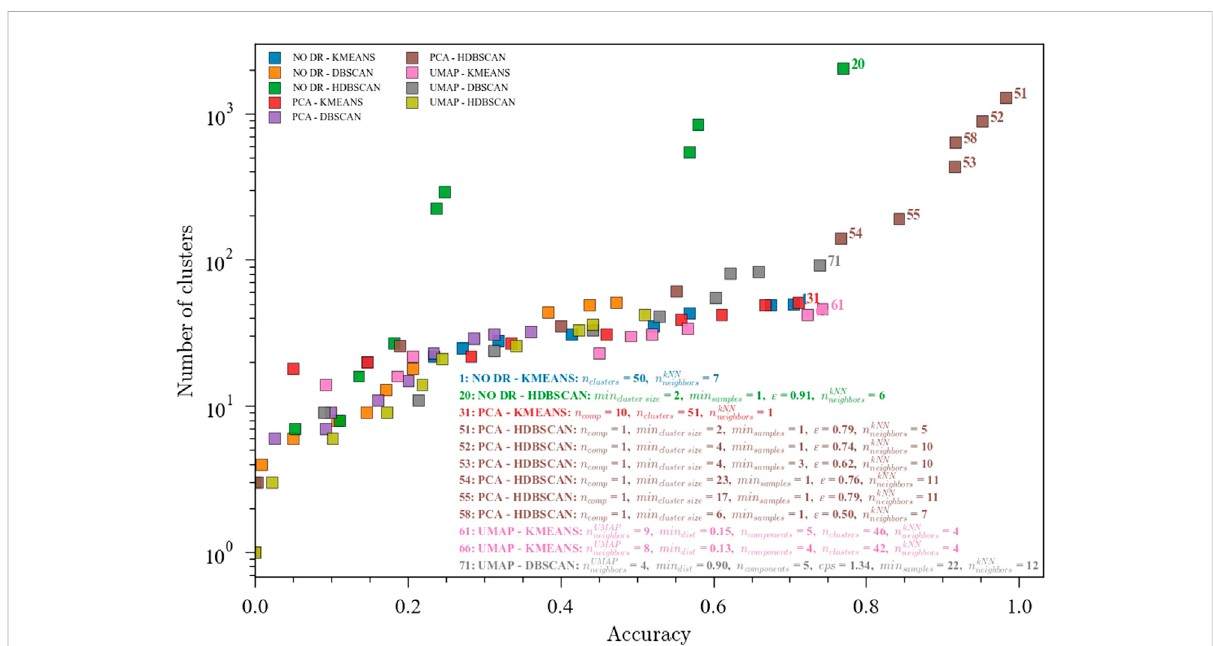
FIGURE 3 Paretofrontsforthemulti-objective(accuracy andnumberofclusters)optimizationoftheensembles.The hyperparametersfortheaccuracies above0.70 areshown. Data fromtheTennesseeEastman Process dataset with 20faults. Ensembles:(1) NO DR-KMEANS, n clusters (cid:1) 50, n kNN neighbors (cid:1) 7; (20) NO DR-HDBSCAN, min cluster size (cid:1) 2, min samples (cid:1) 1, ε (cid:1) 0 . 91, n kNN neighbors (cid:1) 6; (31) PCA-KMEANS, n components (cid:1) 10, n clusters (cid:1) 50, n kNN neighbors (cid:1) 1; (51) PCA-HDBSCAN, n components (cid:1) 1, min cluster size (cid:1) 2, min samples (cid:1) 1, ε (cid:1) 0 . 79, n kNN neighbors (cid:1) 5; (52) PCA-HDBSCAN, n components (cid:1) 1, min cluster size (cid:1) 4, min samples (cid:1) 1, ε (cid:1) 0 . 74, n kNN neighbors (cid:1) 10; (53) PCA-HDBSCAN, n components (cid:1) 1, min cluster size (cid:1) 4, min samples (cid:1) 3, ε (cid:1) 0 . 62, n kNN neighbors (cid:1) 10; (54) PCA- HDBSCAN, n components (cid:1) 1, min cluster size (cid:1) 23, min samples (cid:1) 1, ε (cid:1) 0 . 76, n kNN neighbors (cid:1) 11; (55) PCA-HDBSCAN, n components (cid:1) 1, min cluster size (cid:1) 23, min samples (cid:1) 1, ε (cid:1) 0 . 79, n kNN neighbors (cid:1) 11; (58) PCA-HDBSCAN, n components (cid:1) 1, min cluster size (cid:1) 6, min samples (cid:1) 1, ε (cid:1) 0 . 50, n kNN neighbors (cid:1) 11; (61) UMAP- KMEANS, n UMAP neighbors (cid:1) 9, min dist (cid:1) 0 . 15, n components (cid:1) 5, n clusters (cid:1) 46, n kNN neighbors (cid:1) 4; (66) UMAP-KMEANS, n UMAP neighbors (cid:1) 8, min dist (cid:1) 0 . 13, n components (cid:1) 4, n